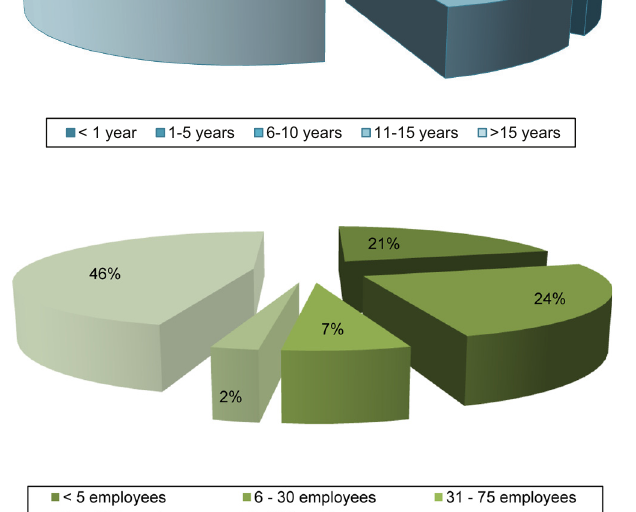
Figure 2. Composition of